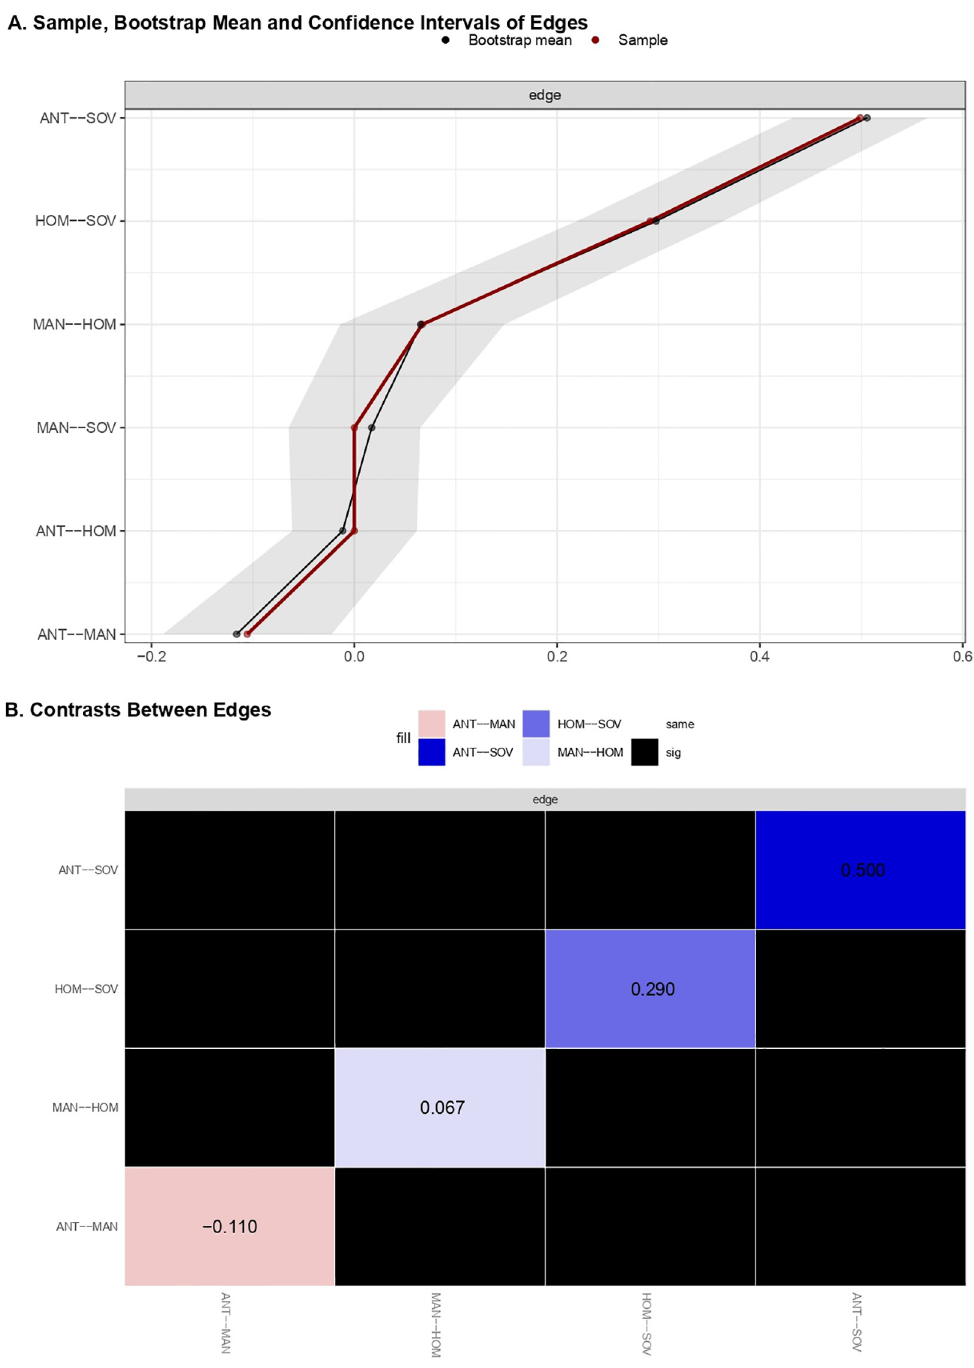
Fig 4. Edge weights of the network of populist ideology dimensions. (A) Sample, bootstrap means and confidence intervals of edge weights resulting from the network model investigating populist narratives’ centrality. (B) Bootstrap differences of edges weights resulting from the network model investigating populist narratives’